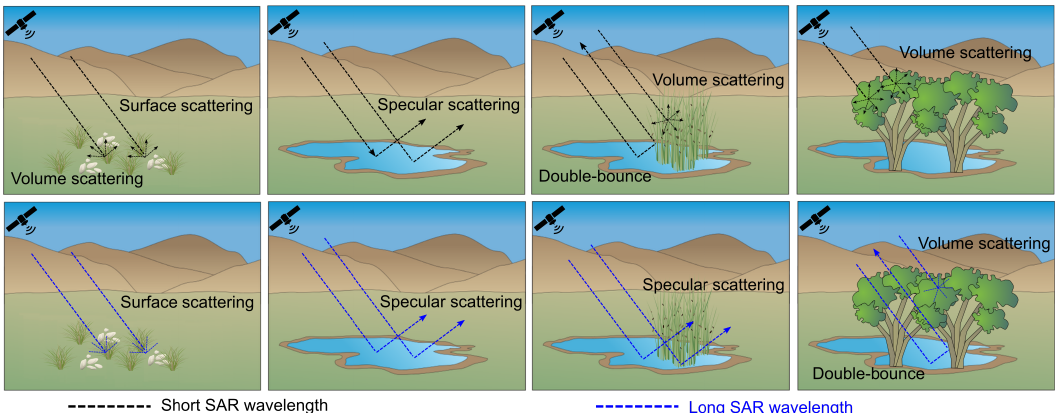
Figure 3. Simplified schematic illustration of the dominant backscatter mechanisms for short (e.g., X, 3.1 cm) and long (e.g., L, 23.6 cm) wavelengths for various surface cover conditions related to